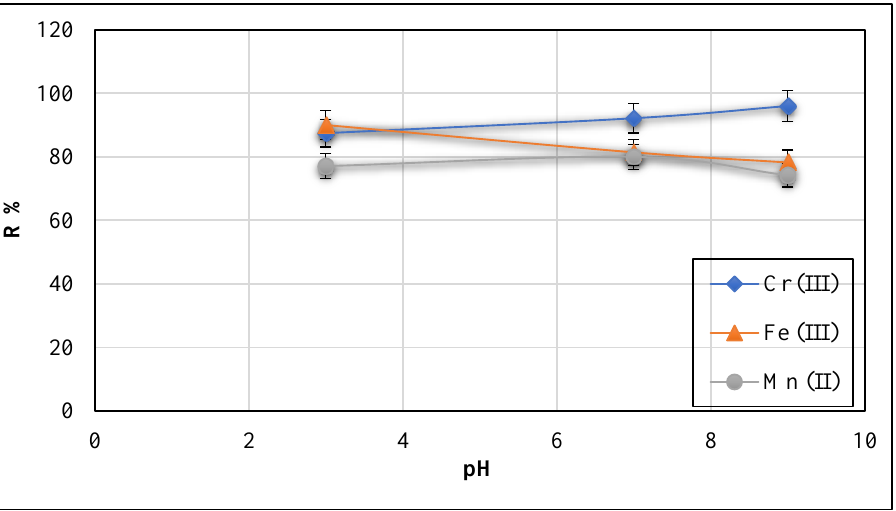
Figure 12. Effect of solution pH on Cr (III), Fe (III), and Mn (II) adsorption onto Ch/g-HNTs@Zn γ M adsorbent at 30 °C and concentration of 20 mg/L.